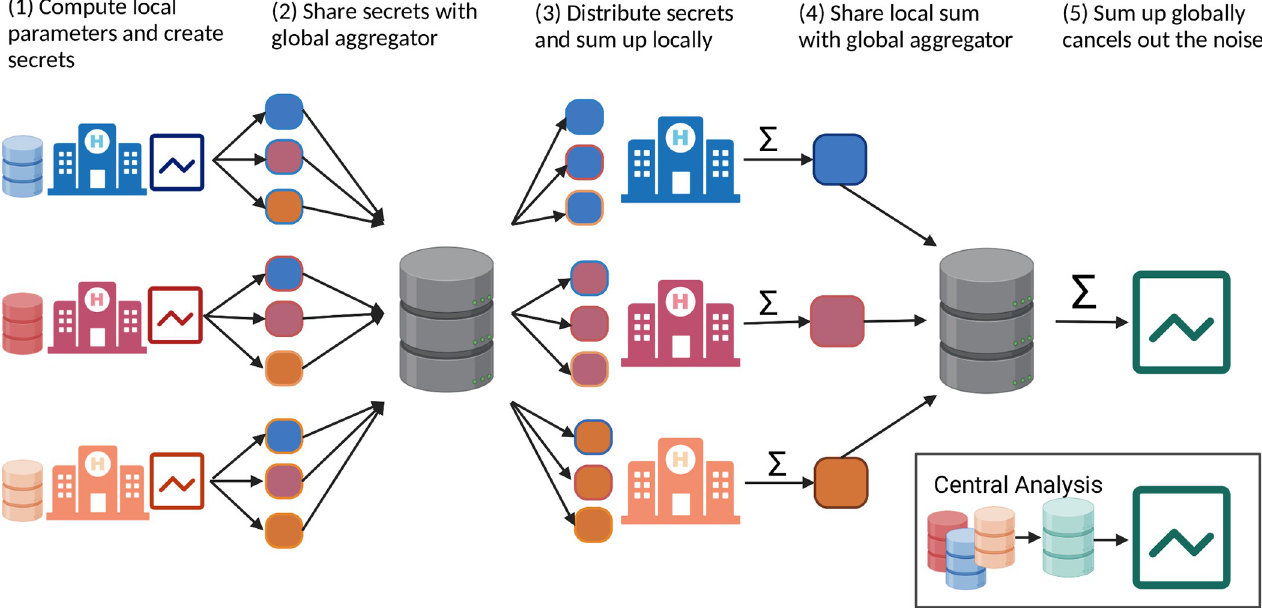
Fig 1. Hybrid federated learning workflow using additive secret sharing. Each institution calculates its local statistics and creates a secret for each participant (1). The global aggregation server receives the secrets and distributes them to the corresponding participants (2). Each local client decrypts the secrets and sums them up (3). The sum is shared with the global aggregation server (4), which sums them up again, revealing the final global aggregation (5). Created with Biorender.com.